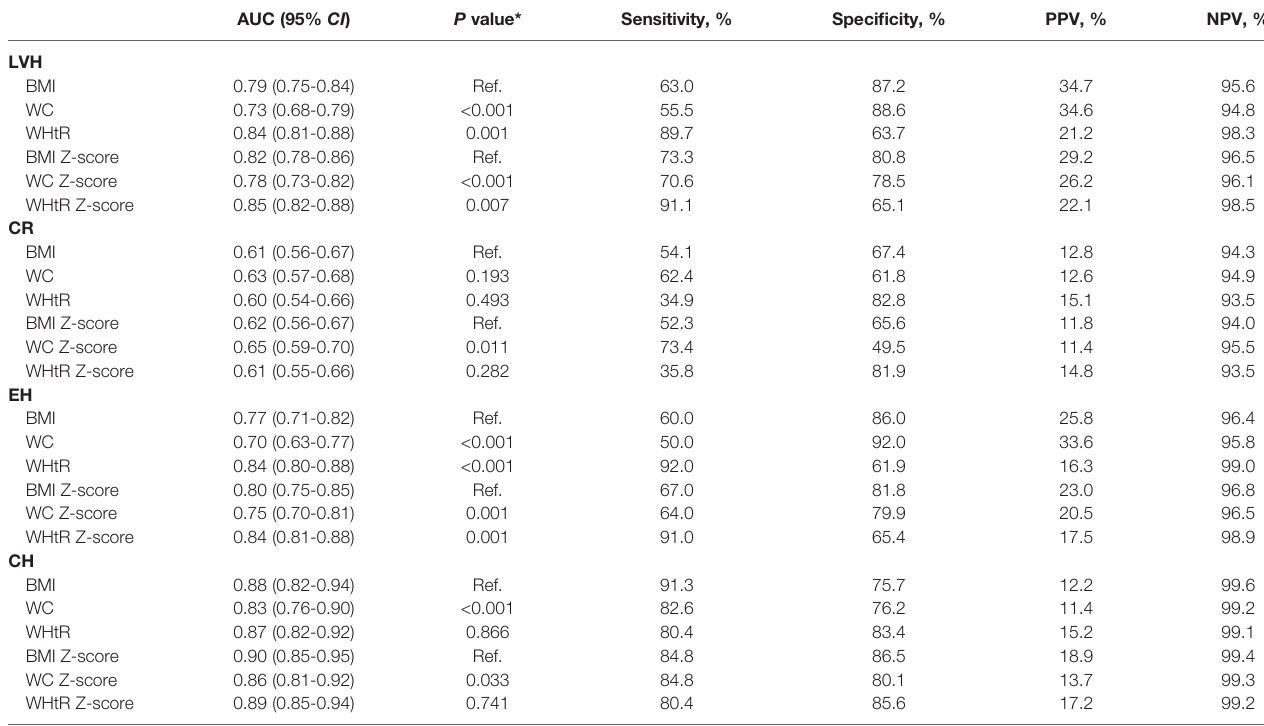
LVH, left ventricular hypertrophy; CR, concentric remodeling; EH, eccentric hypertrophy; CH, concentric hypertrophy; BMI, body mass index; WC, waist circumference; WHtR, waist-to- height ratio; AUC, area under the operating characteristic curve; CI, con fi dence interval; PPV, positive predictive value; NPV, negative predictive value; Ref, referent. *Comparisons of AUCs with BMI as the